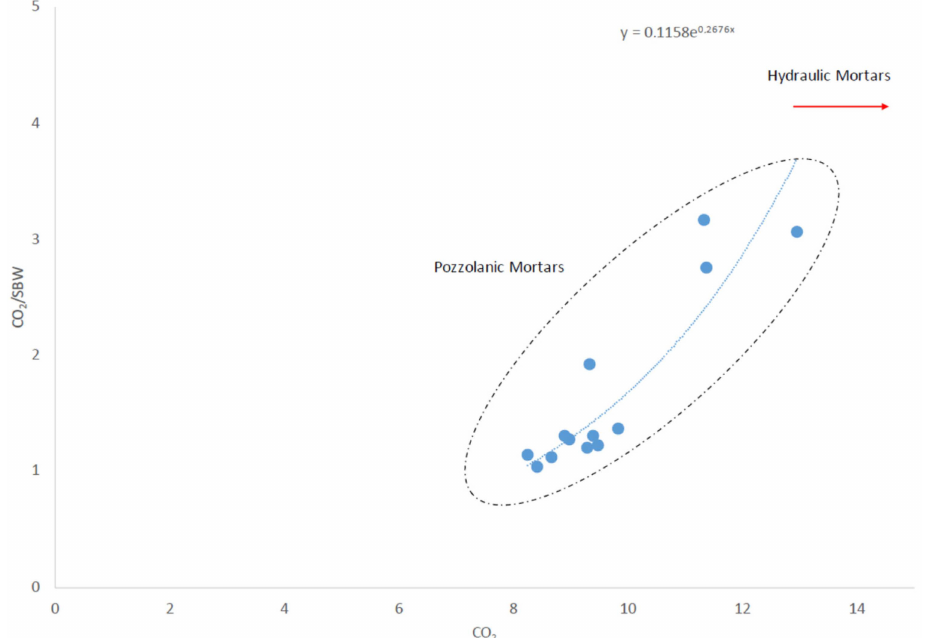
Figure 3. Hydraulic classification of mortars through the CO 2 /SBW ratio. CO 2 refers to the loss in weight (%) in the range of 600–850 ◦ C, and SBW (Structural Bound Water) refers to that in the range of 200–600 ◦